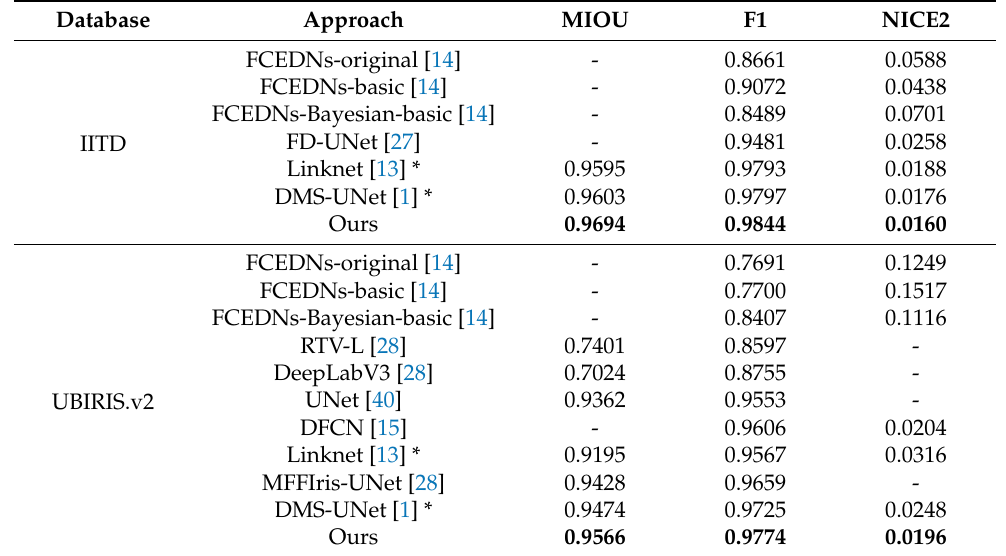
Table 6. Comparison with algorithms based on CNNs on two iris